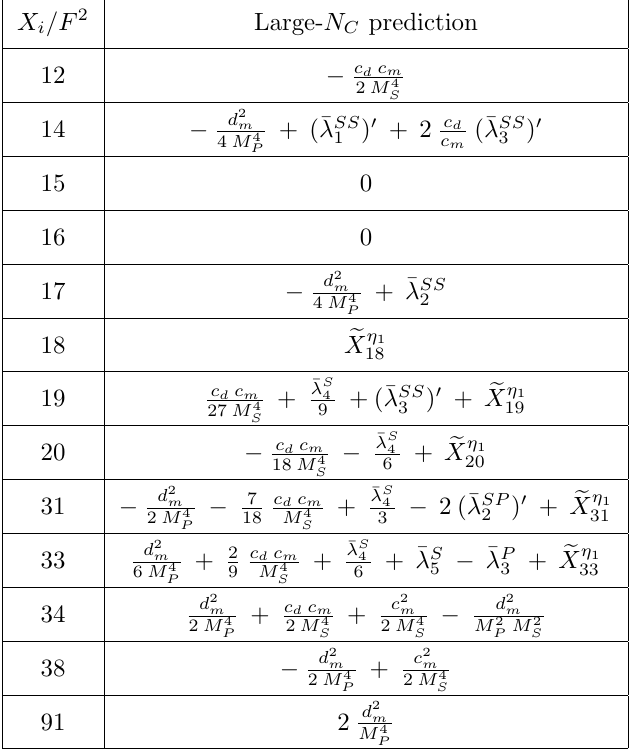
Table 3 . Large- N C predictions for the relevant strong LECs of O ( p 6 ), in F 2 units